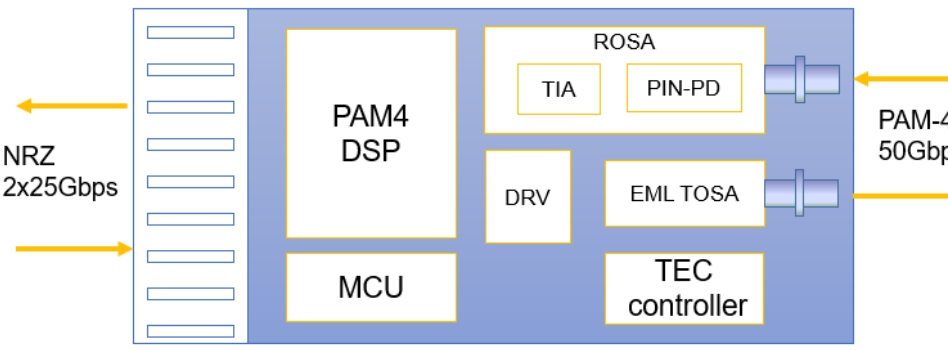
Figure 5. QSFP28 hardware design block